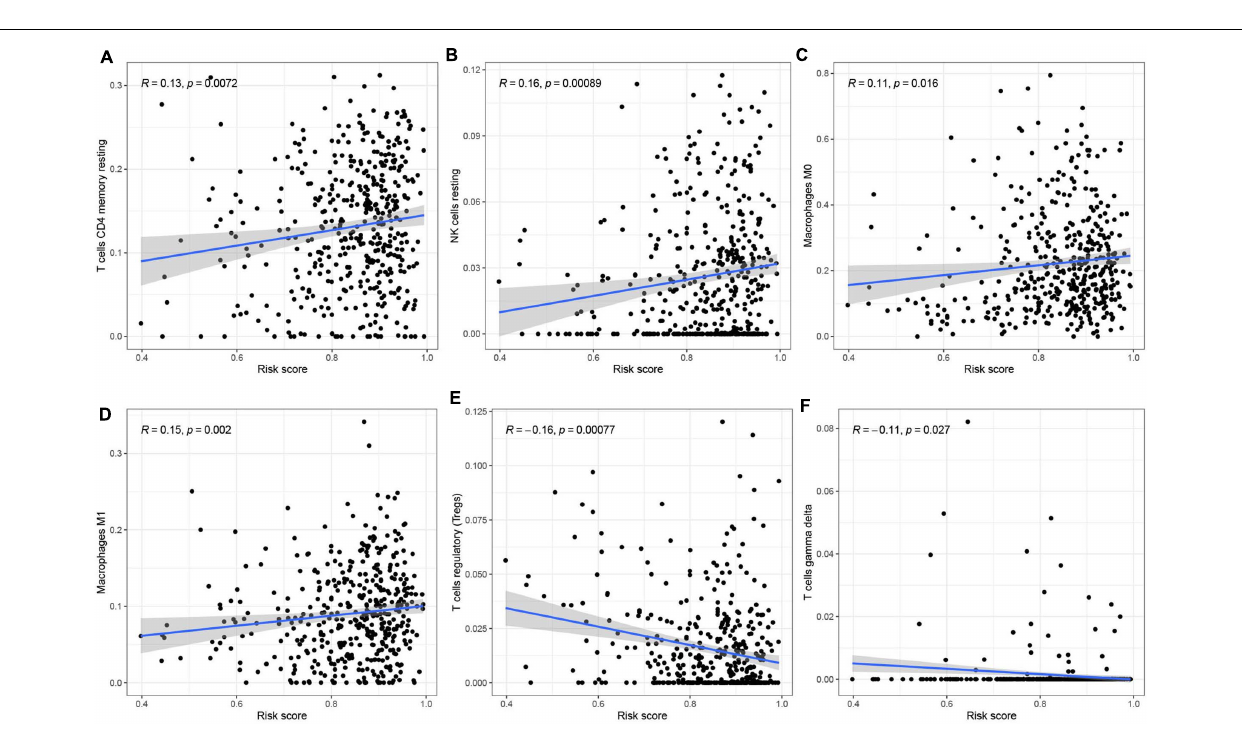
Frontiers in Cell and Developmental Biology |